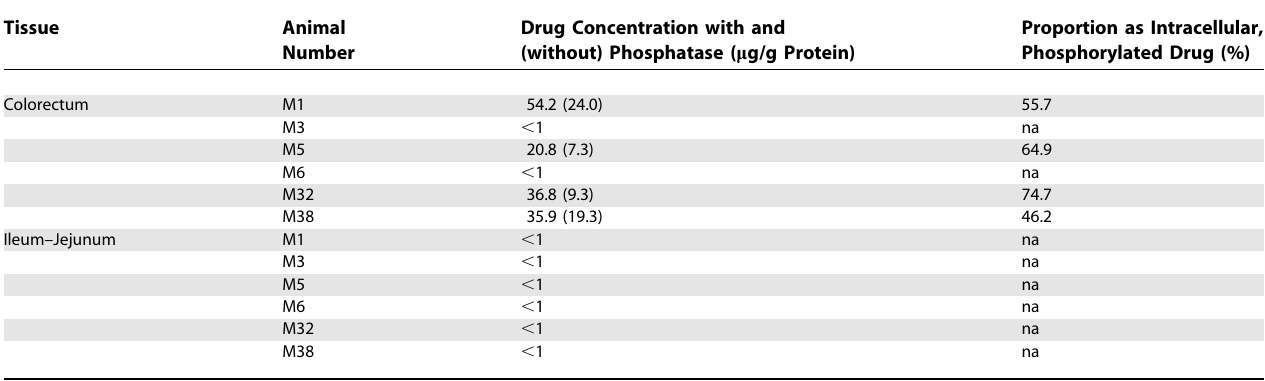
Table 6. Intracellular Concentrations of Base and Phosphorylated Tenofovir in Colorectal and Ileum–Jejunum of Macaques Given Tenofovir Gel Rectally